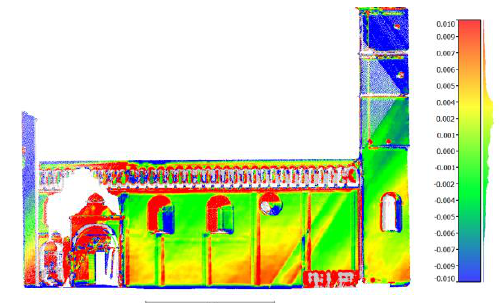
Figure 11. Colour-coded map of the comparison analysis between MMS and TLS data in the Cathedral dataset. The scale ranges from – 0.01 m (blue) to 0.01 m (red).